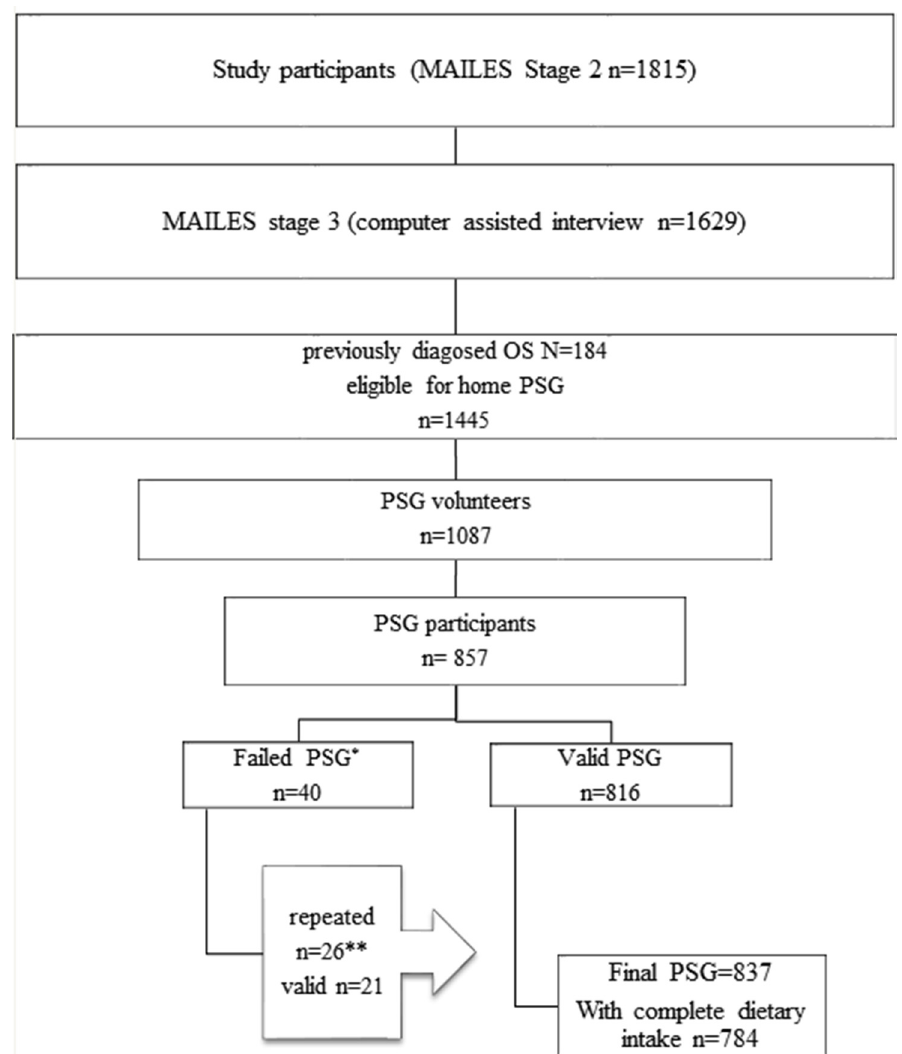
Figure 1. The flow chart of study participants with dietary intake (MAILES stage 2) and MAILES stage 3 with PSG recruitment * n = 21 total sleep time (TST) not ≥ 3.5 h from ≥ 5 h recording; n = 3